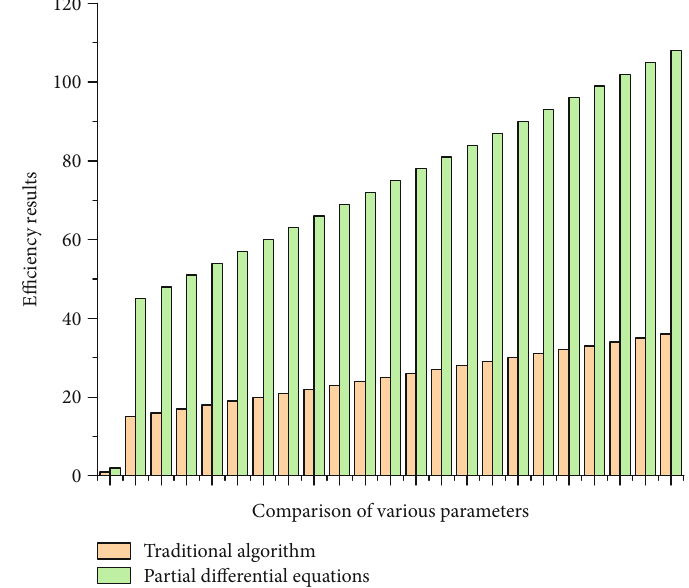
Figure 6: Comparison of the e ffi ciency of di ff erent image restoration models.